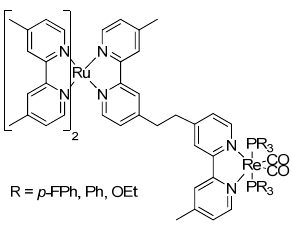
Figure 16. Modified Ru-Re complexes with phosphorus